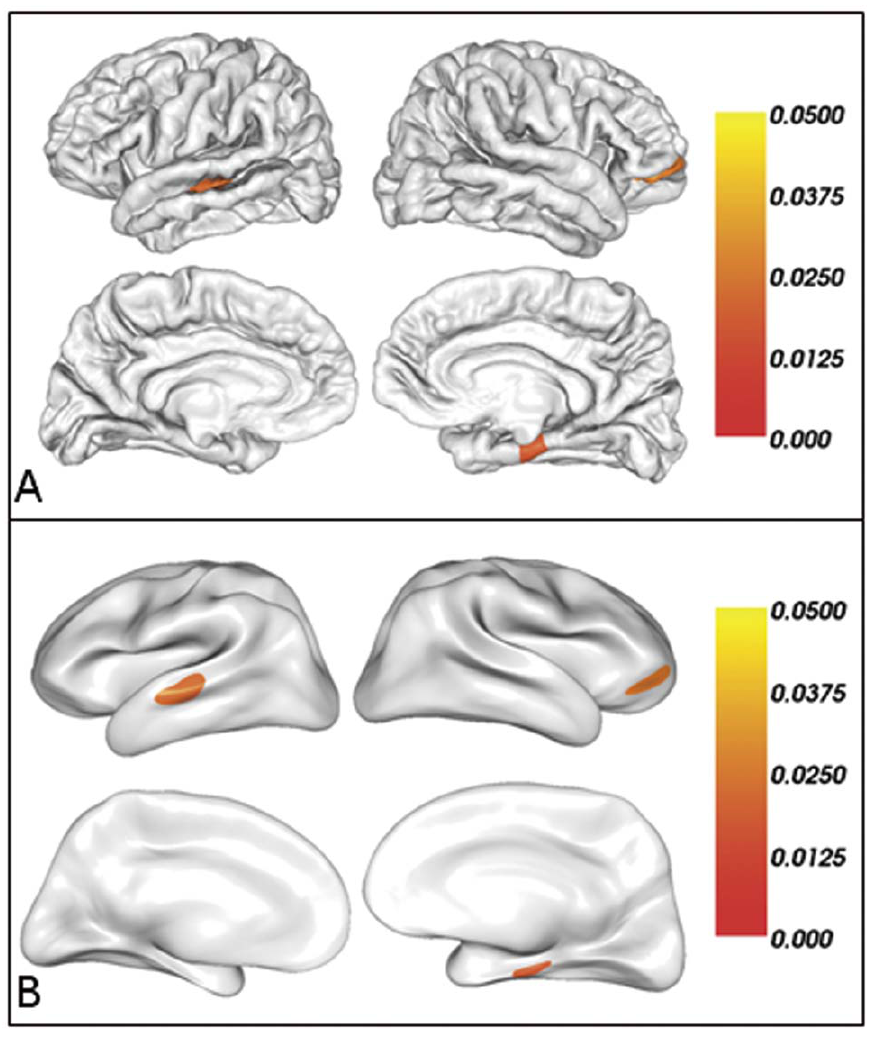
Figure 1. Brain regions with increased cortical thickness in expert compared with novices after a correction for multiple comparisons (P , 0.05, the cluster-based RFT correction) on the pial surface. The color bar indicates the cluster-wise p -value after the correction for multiple comparisons.